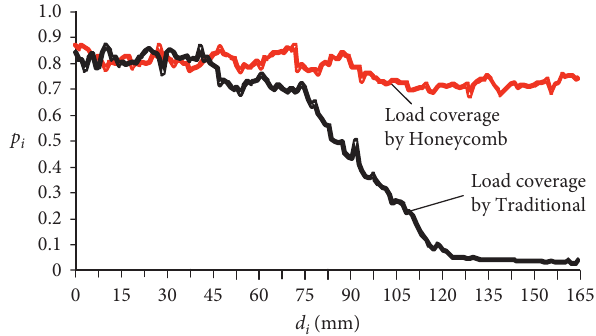
Figure 13: Experiments of load coverage probability of a new ultrasonic vibration network unit.